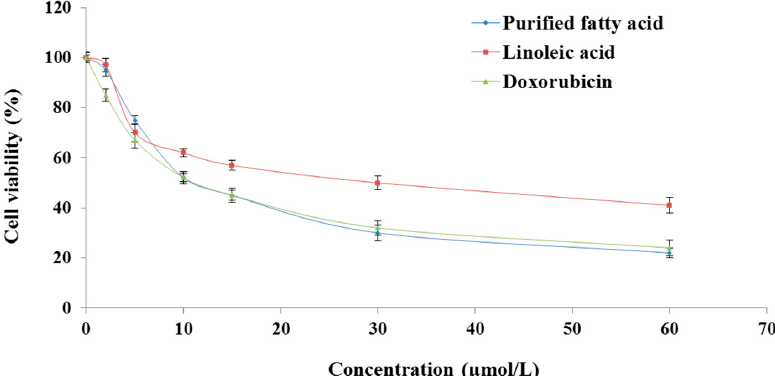
Figure 2. In vitro cytotoxic effects of purified fatty acid from A. spinosus , linoleic acid, and doxorubicin in HepG2 cells. HepG2 cells were seeded in a 96-well plate (10,000 cells/well) 24 h prior to the addition of each test material. Following 48h incubation with the extract, cell proliferation was determined by the 3-[4,5-dimethylthiazol-2-yl]-2,5-diphenyltetrazolium (MTT) assay. Each data point represents mean ± standard deviation based on quadruplicate determinations in three to five independent experiments.